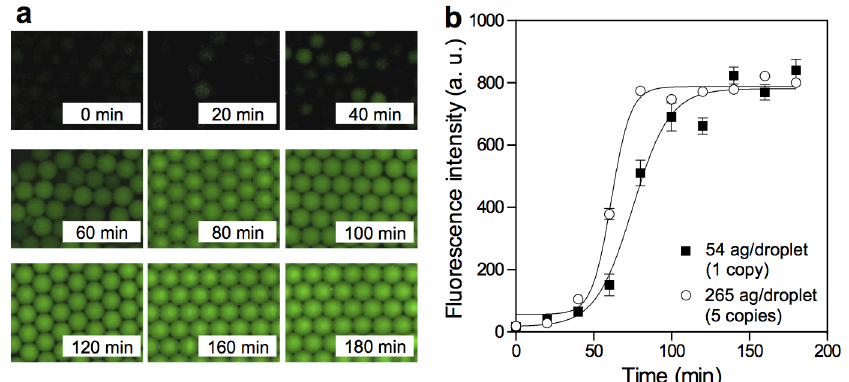
Fig 2. Droplet MDA of low-input lambda DNA. (a) Sequential fluorescent images of droplets encapsulating lambda DNA at a concentration of 265 ag/droplet (5 copies lambda DNA per droplet) with Evagreen dye. (b) Time-dependent appearance of the fluorescence signal during compartmentalized amplification of the denatured lambda DNA (input concentration 54 ag/droplet (1 copy lamda DNA per droplet) and 265 ag/ droplet). All data are presented as averaged intensities of fluorescent positive droplets measured with SEM, and 100 droplets were analyzed at each time